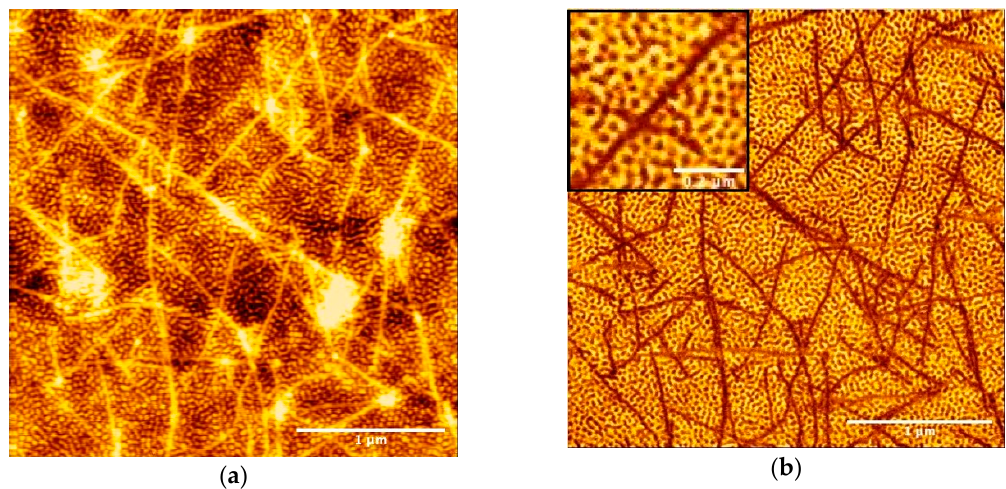
Figure 2. ( a ) SFM topographic and ( b ) phase images of the thin film obtained by spin-casting the suspension of poly(3-hexylthiophene) (P3HT) (0.05 wt%) and SBS (0.5 wt%) in the mixture of chloroform and anisole (70:30 ( v / v )) (3 × 3 µ m). In both the images, the microphase separation of SBS and the nanofiber formation of P3HT could be observed. Top left inset of ( b ) shows the magnified image of the phase image.